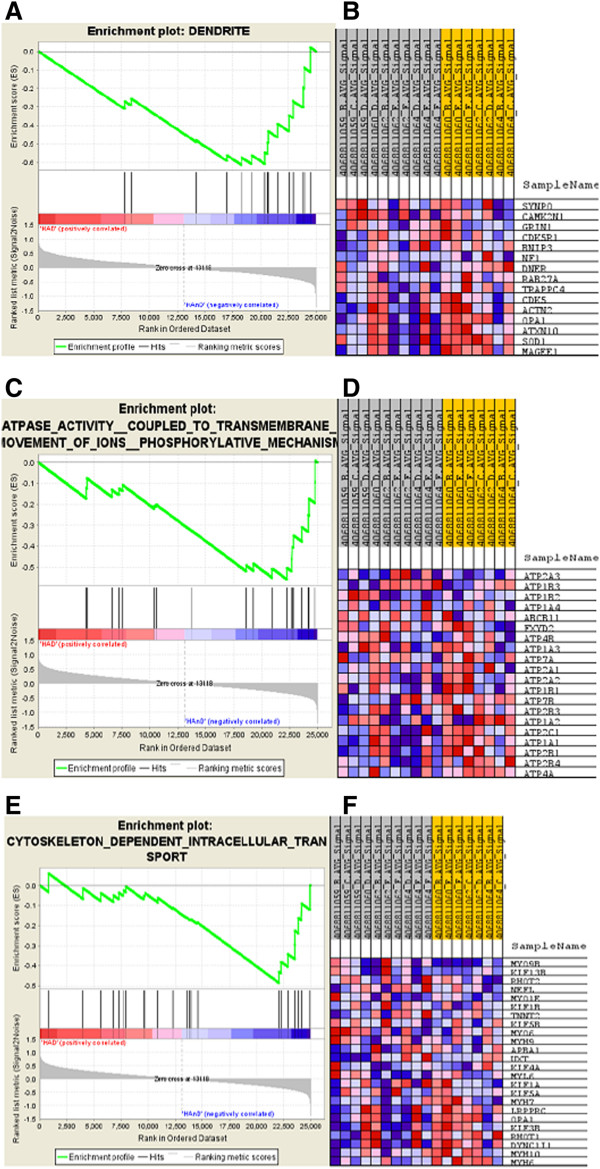
Enrichment plots and heat maps for the gene sets of dendrite, ATPase activity coupled to ion transmembrane movement and cytoskeleton dependent intracellular transport generated by GSEA. (A) Enrichment plot for the gene set of dendrite. Y-axis: value of the ranking metric; X-axis: the rank for all genes. Bottom: plot of the ranked list of all genes. Genes whose expression levels are most closely associated with the HAD or HIV non-dementia group are located at the left or right edge of the list while genes from the gene set dendrite within the ranked list are located at the middle. Top: the running enrichment score for the gene set as the analysis walks along the ranked list. The score at the peak of the plot is the enrichment score (ES) for this gene set and those genes appear before or at the peak are defined as core enrichment genes for this gene set. (B) Heat map of the core enrichment genes of the dendrite gene set, which contributes most to the ES. Rows: gene; columns: samples. Range of colors (red to blue) indicates the range of expression values (high to low). (C) Enrichment plot for the gene set of ATPase activity coupled to ion transmembrane movement. (D) Heat map of the core enrichment genes of the gene set ATPase activity coupled to ion transmembrane movement. (E) Enrichment plot for the gene set of cytoskeleton dependent intracellular transport. (F) Heat map of the core enrichment genes of the gene set cytoskeleton dependent intracellular transport.